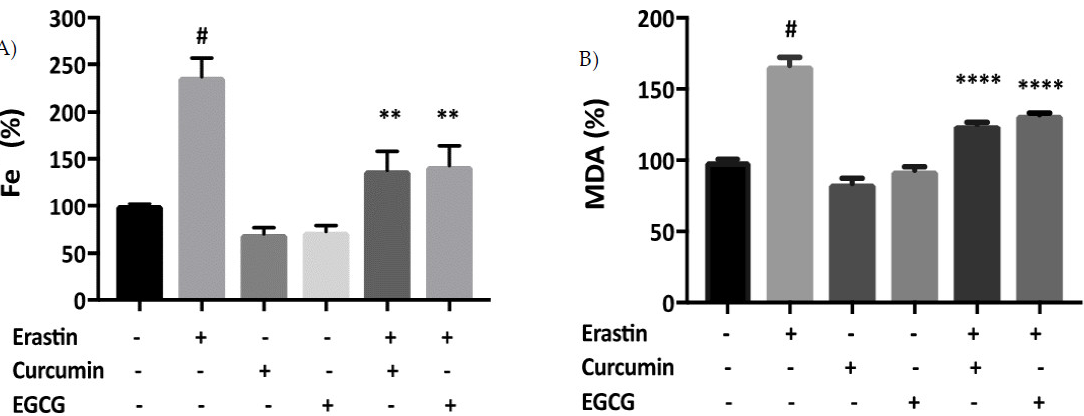
Figure 3. Curcumin and EGCG suppress iron and lipid accumulation in pancreatic cells. ( A ) Cells were treated overnight with 20 µ M erastin in the absence or presence of curcumin or EGCG. Percentage of Fe 2+ is relative to control cell samples. Curcumin and EGCG decreased erastin-induced iron accumulation at 20 µ M in MIN6 for 24 h, with significant statistical difference between erastin and cell treated with erastin + 20 µ M curcumin or EGCG. ( B ) Percentage of MDA is relative to control cell samples. Curcumin and EGCG decreased erastin-induced lipid peroxidation at 20 µ M in MIN6 for 24 h, with valuable statistical difference between erastin and cell treated with erastin + 20 µ M curcumin or EGCG. All the values are expressed with the mean ± SEM, n = 3, # p < 0.05 control vs. treatment groups, **p < 0.01 and **** p < 0.0001 vs. erastin only. One-way ANOVA, Tukey post-hoc test.